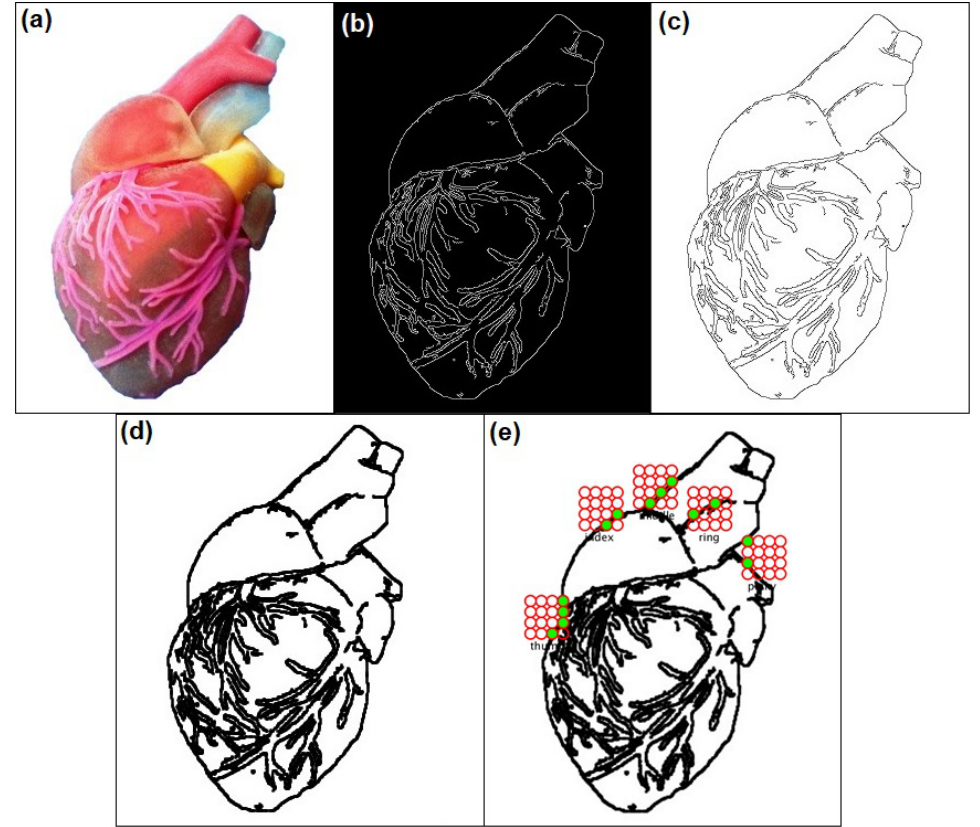
Figure 11. Edge detection using Canny edge algorithm with Hough transform to thicken the lines. ( a ) RGB image of a heart, ( b ) Canny edge result (white lines in black background), ( c ) inverted Canny edge, ( d ) thickened Canny edge using Hough transform, and ( e ) edge detection with tactile matrices simulator.